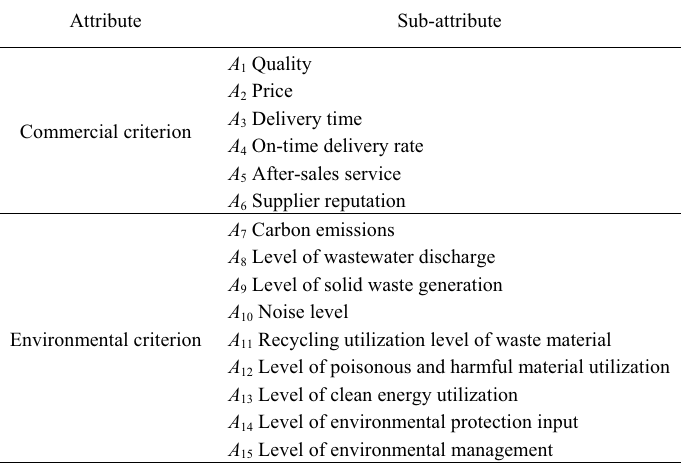
Table 1. Evaluation system of green supplier